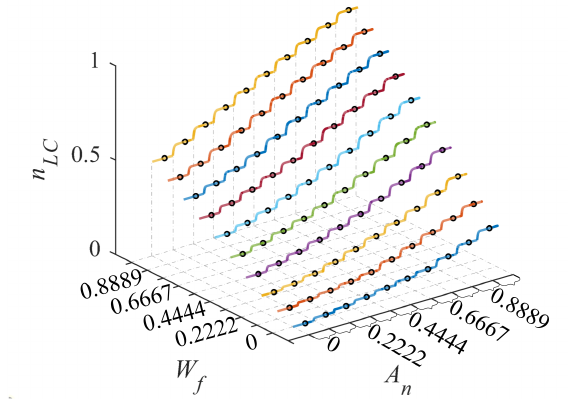
Figure 3. The simulation results of n LC under ten simulation